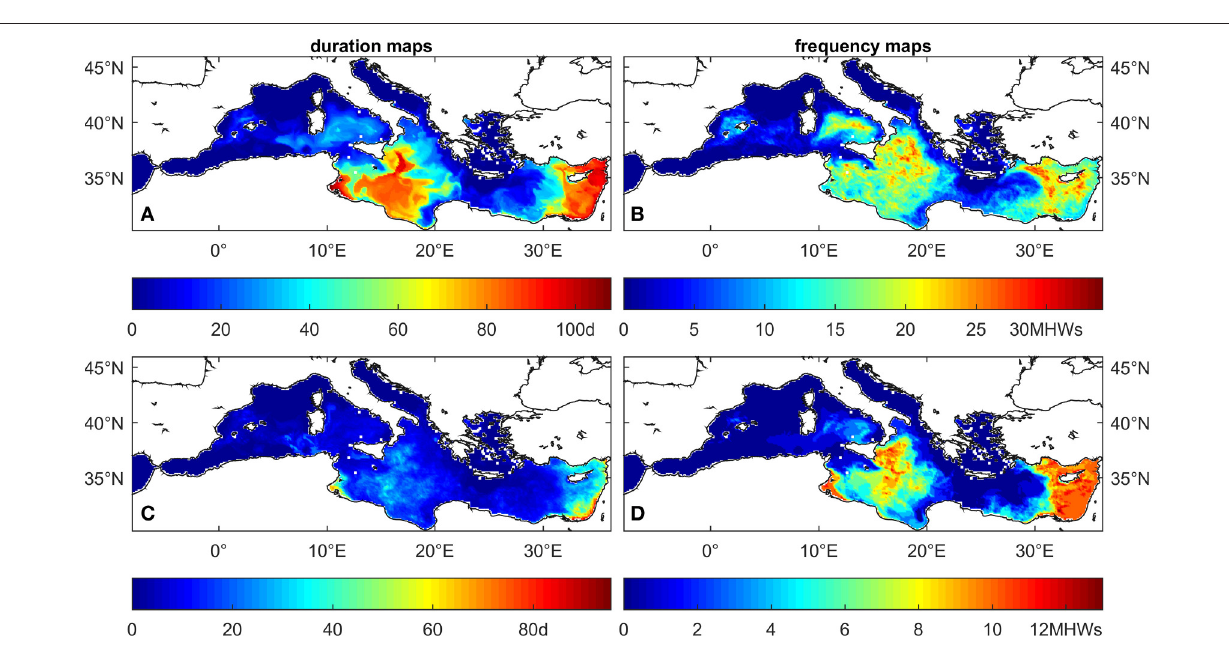
FIGURE 3 | Examples of the maps that constitute the hazard layer for reference temperature T * = 28 ◦ C at 5m depth for the reference period 2001–2010. (A) maximal duration of all MHWs with T ≥ T * , (B) number of MHWs (frequency) with T ≥ T * , (C) average duration of all MHWs with T ≥ T * , (D) frequency of MHWs with T ≥ T * and duration ≥